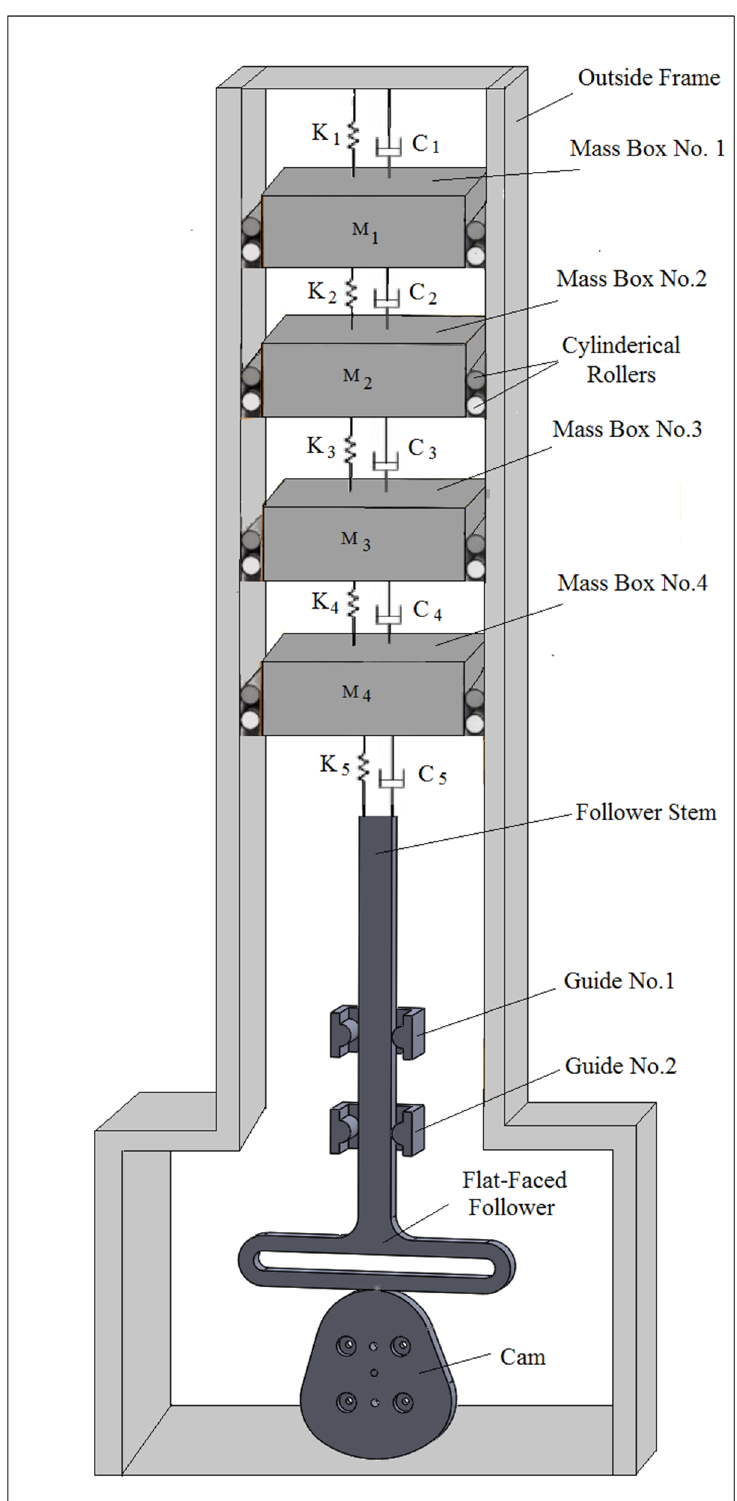
Figure 5. Computer aided design of SolidWorks simulation using multi-degrees of freedom. Multi-degrees of freedom was used to reduce the detachment between the cam and the follower and to improve the dynamic performance through the reduction in the peak of the nonlinear response of the follower as shown in Figure 6. The peak of nonlinear response of the follower displacement was reduced to (15%, 32%, 45%, and 62%) after using multi-degrees of freedom systems. Four spring-damper-mass systems are used at the very